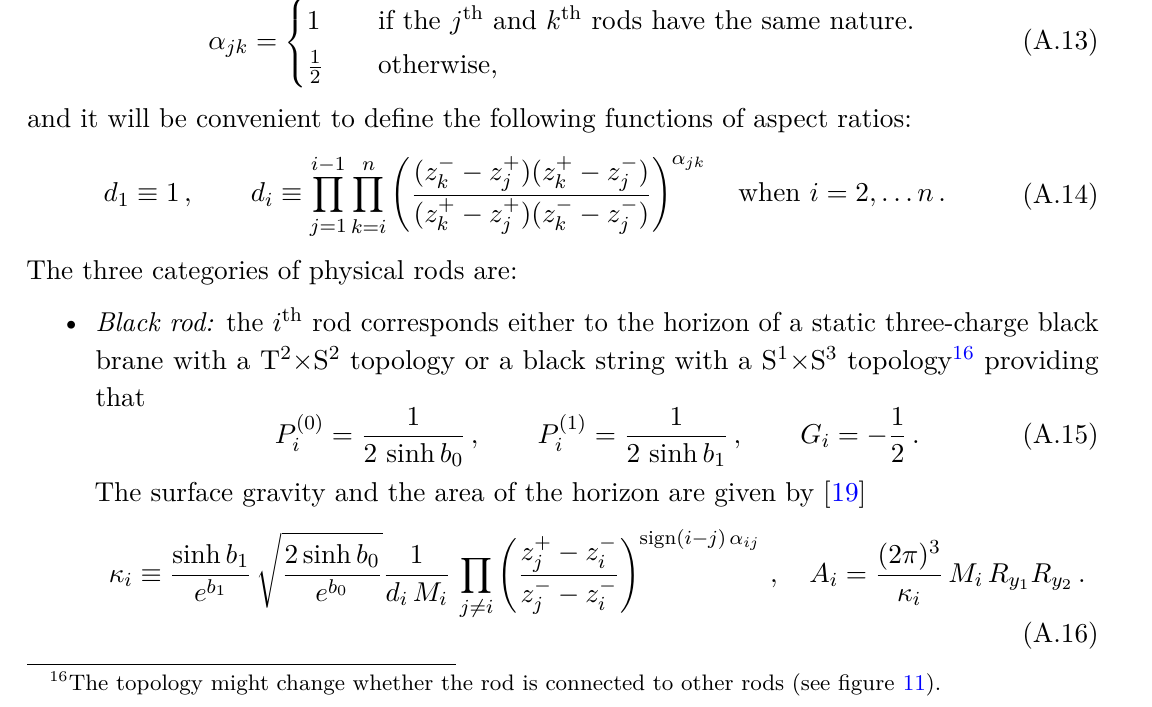
-circle inducing 1